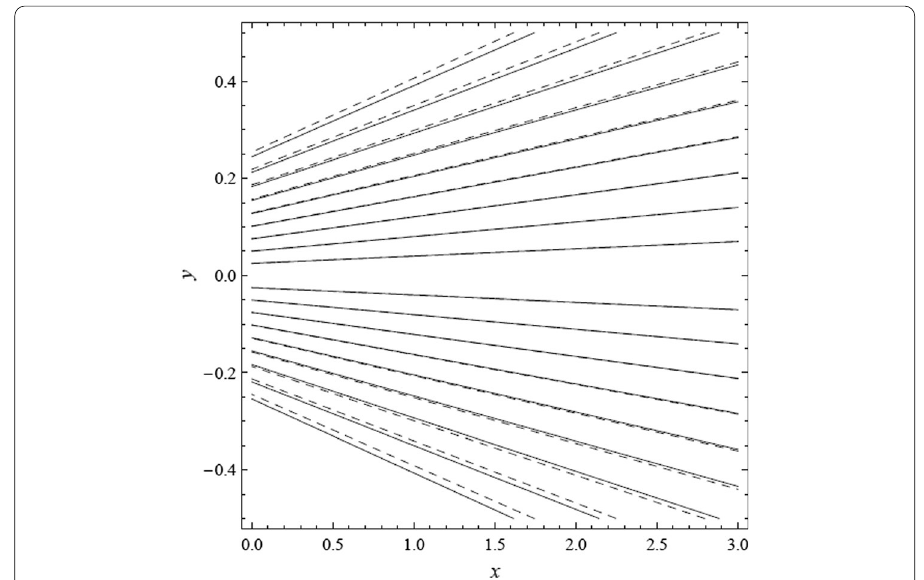
Fig. 5 The stream line y is graphed against the parameters x which show the solid line by (Re and dotted line by (Re